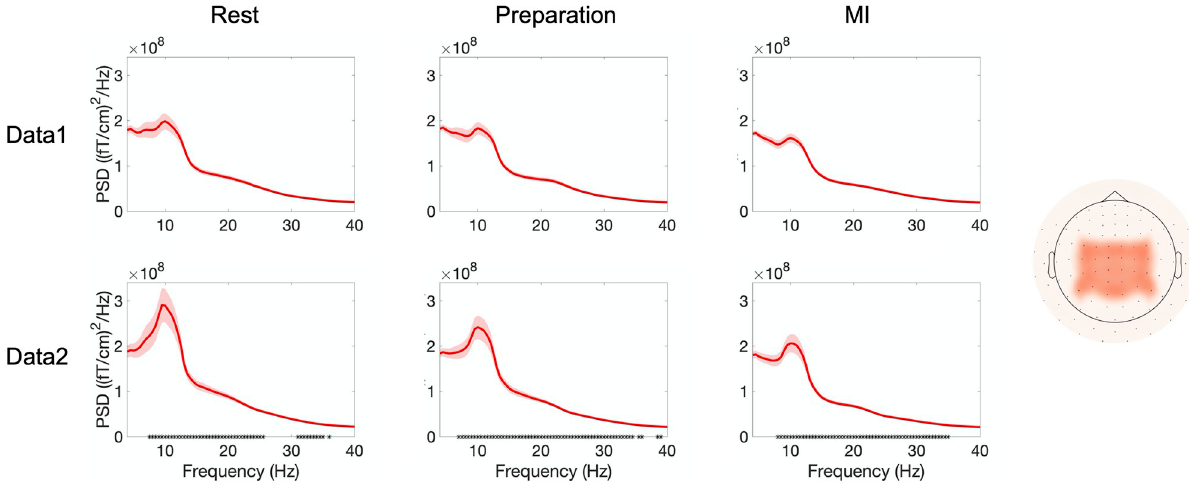
Fig 5. Frequency spectra averaged over parietal gradiometers. Frequency spectra (average across parietal gradiometers, shown in the rightmost column) when delivering visual (Data 1) and proprioceptive (Data 2) feedback, separately during rest, preparation and MI. Frequencies showing a significant ( p < 0.05) linear power increase over trials are marked on the frequency axis with asterisks. Shaded areas represent the standard error of the mean (SEM) over subjects.